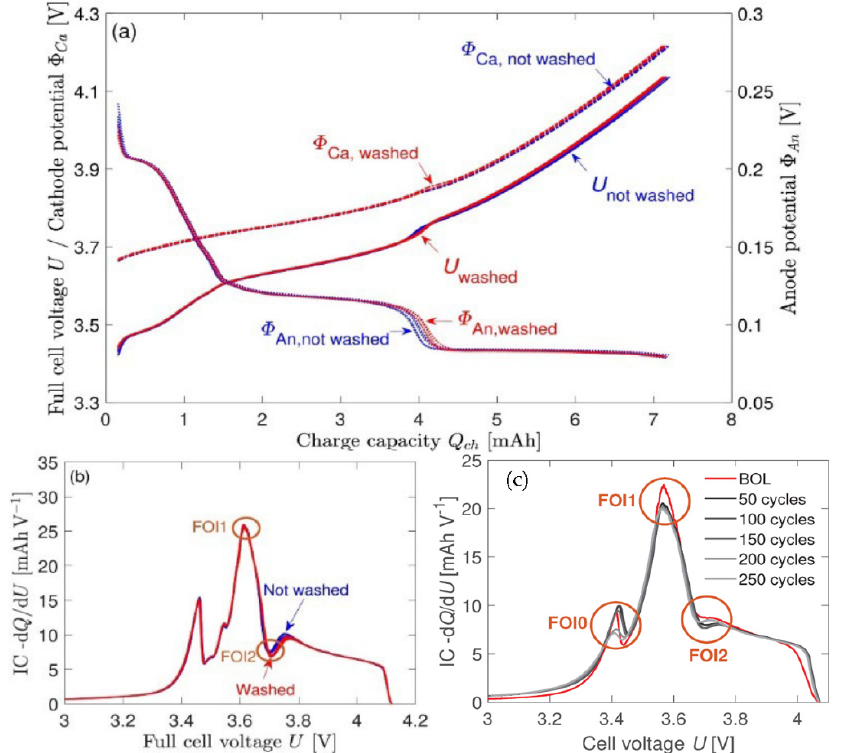
Figure 3. ( a ) Open circuit potentials before coin cells begin aging; ( b ) IC of the full cell voltage; ( c ) defined features of interest (FOIs) of the incremental capacity (IC) curves [43,49]. Reprint with permission [43]; Copyright 2019, Elsevier. Reprint with permission [49]; Copyright 2020, MDPI.